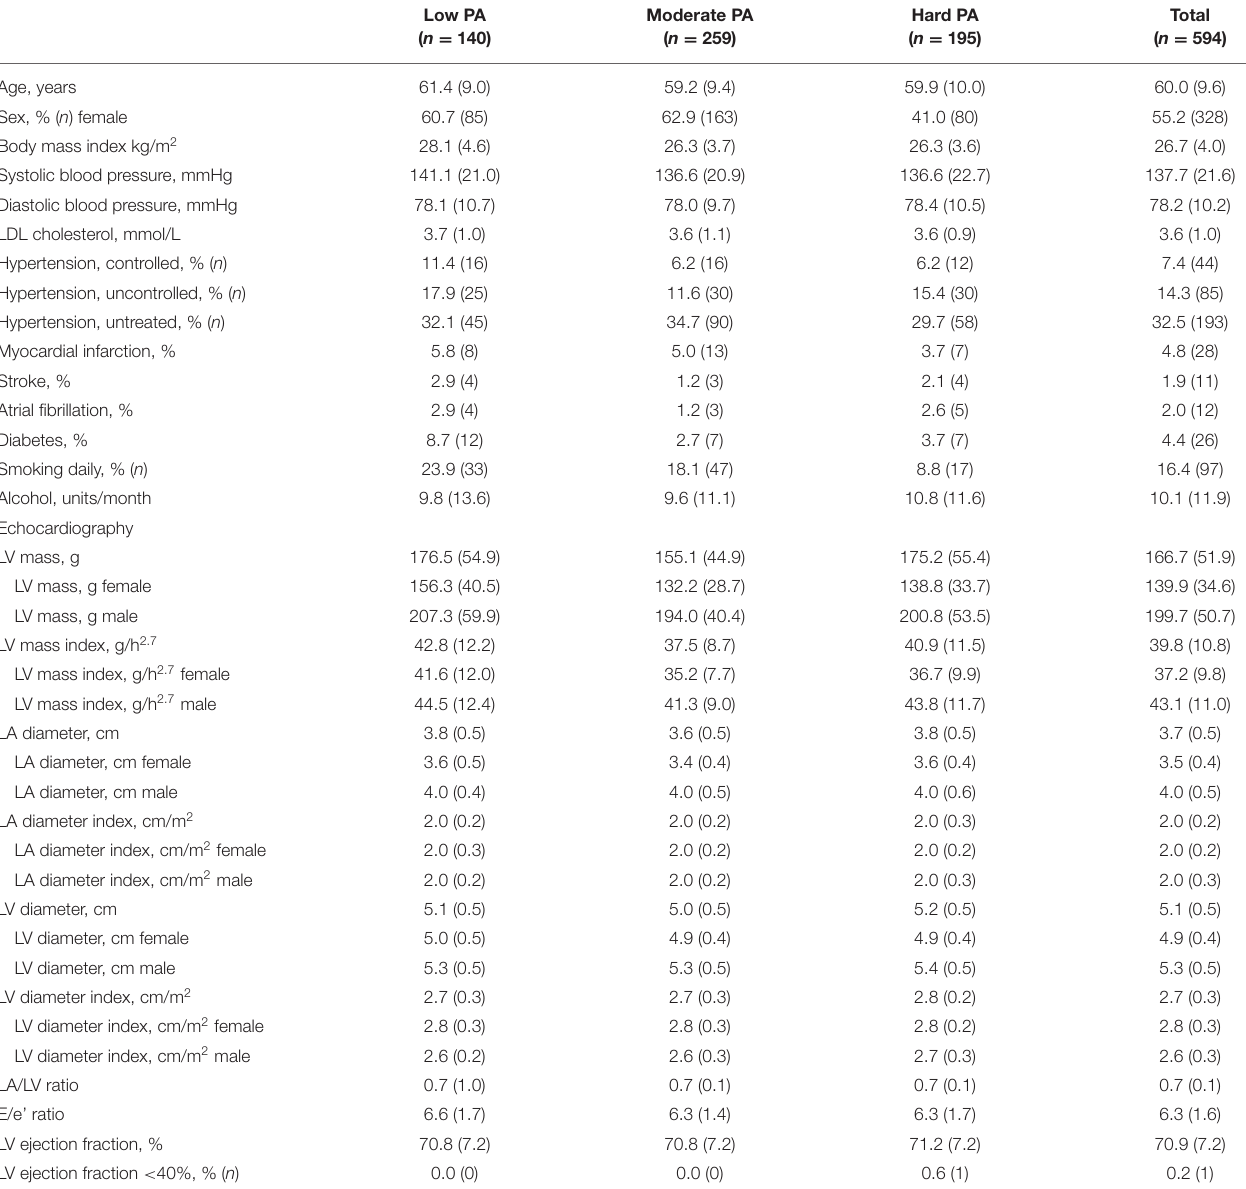
TABLE 1 | Descriptive baseline characteristics stratified by level of cumulative physical activity: The Tromsø Study